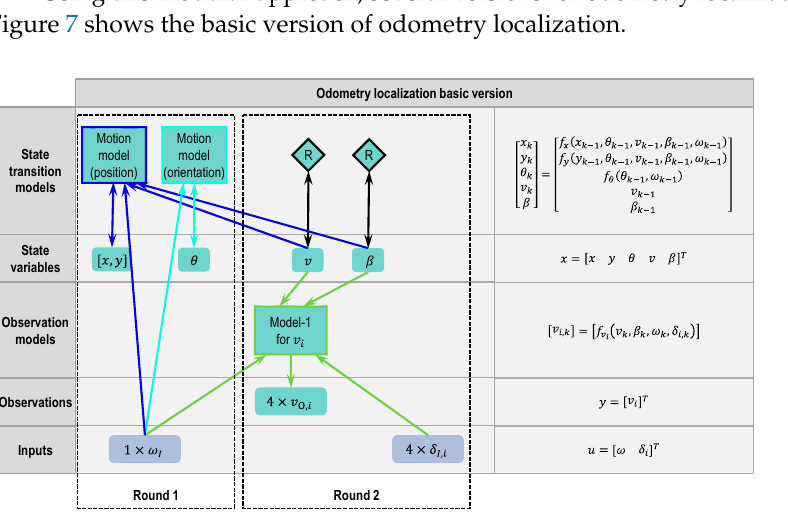
Figure 7. Modular approach to designing a state estimator for odometry localization (basic ver- sion).